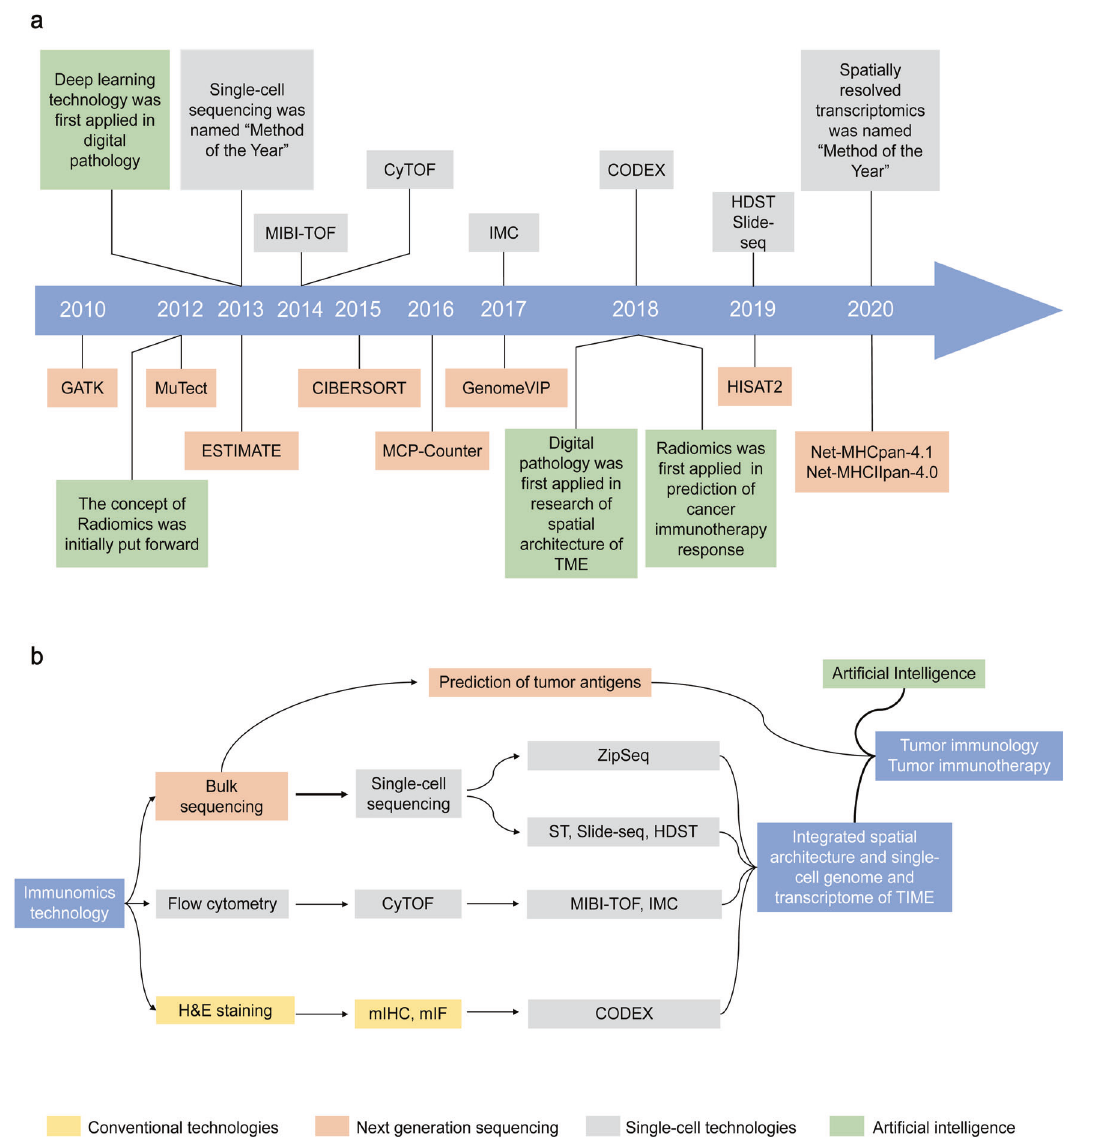
Fig. 4 A landscape of immunomics: developmental tendency and future direction. a The timeline of immunomics technologies. b Historical development trajectory and future prospective of tumor immunomics. CODEX codetection by indexing, CyTOF cytometry by time-of-light, ESTIMATE estimation of stromal and immune cells in malignant tumors using expression data, GATK Genome Analysis Toolkit, GenomeVIP Genome Variant Investigation Platform, HDST high-de fi nition spatial transcriptome, IMC imaging mass cytometry, MCP-counter microenvironment cell populations-counter, MIBI-TOF multiplexed ion beam imaging by time-of- fl ight, mIF multiplex immuno fl uorescence, mIHC multiplex